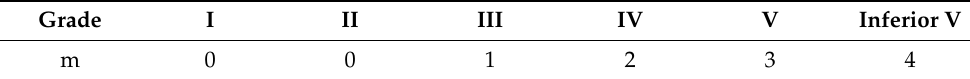
Table 1. Amendment values for different water quality